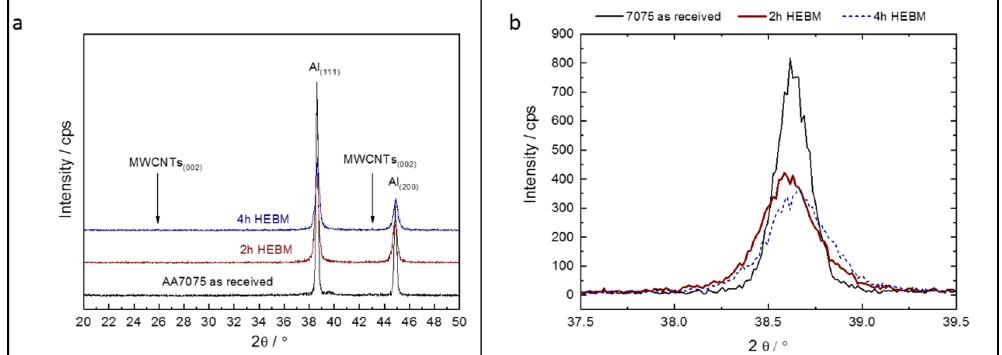
Figure 9. ( a ) XRD patterns of 7075-1 wt.% MWCNT composite powders milled for 2 h and 4 h compared to those of the as-received AA7075 powders. ( b ) Enlargement of (111) peak.